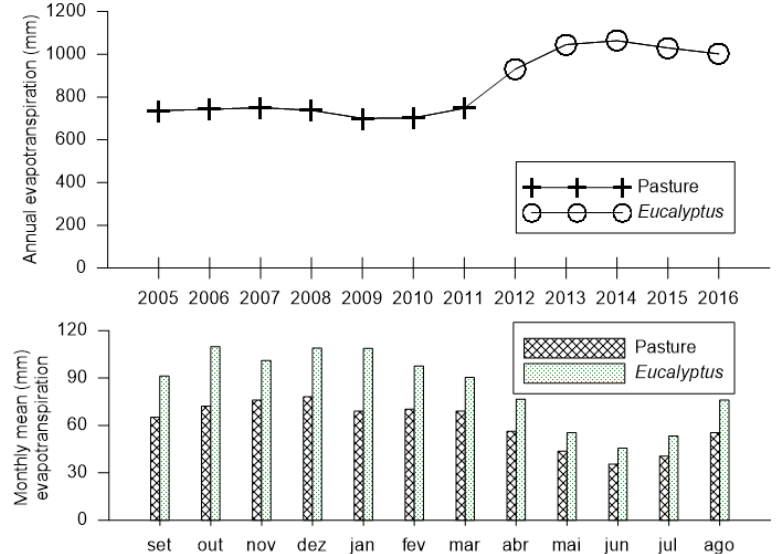
Figure 7. Annual and monthly evapotranspiration in the study area.